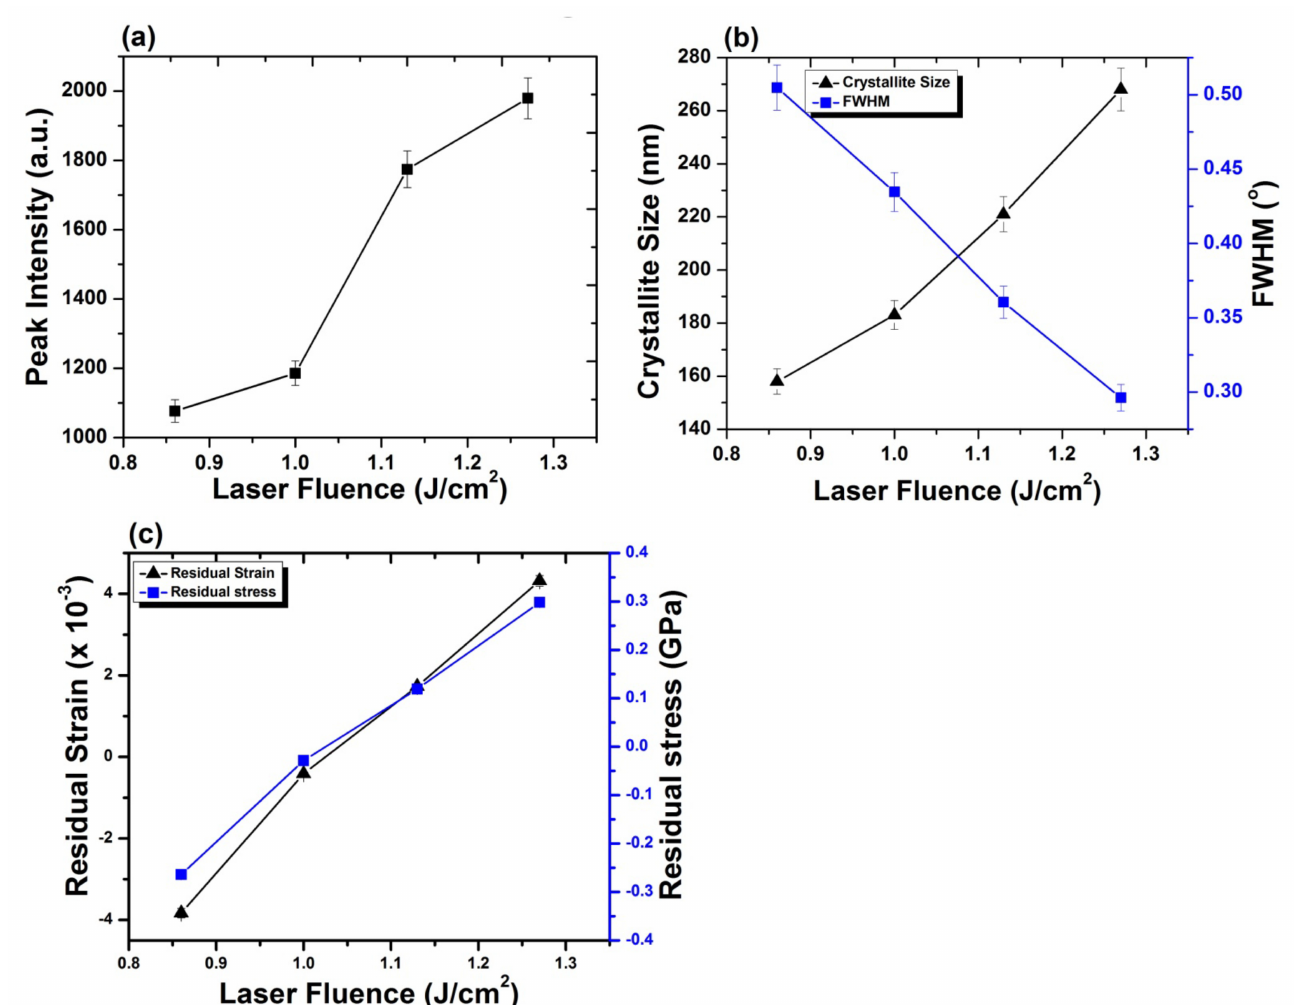
Figure 8. ( a ) The variation in peak intensity, for Al (200) orientation plane, with variation of laser fluence from 0.86 to 1.27 J · cm − 2 , under Ar ambient for 100 laser pulses at pressure of 100 torr; ( b ) the variation in crystallite size, FWHM; and ( c ) relation between residual strain and residual stress with variation of laser